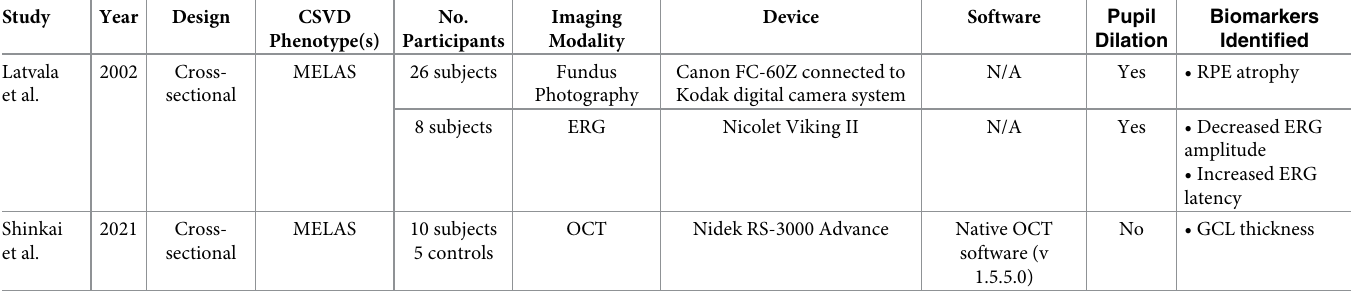
Table 7. Summary of design, patient characteristics, methodology and results for studies of MELAS.